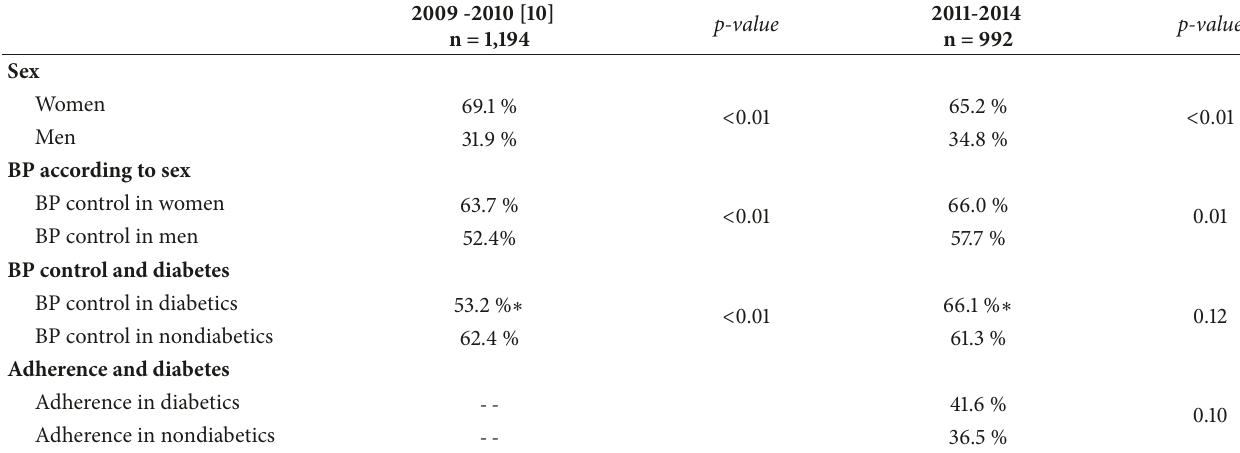
Table 4: Comparative values of BP control by sex, presence of diabetes, and adherence in the evaluation of two different groups from the